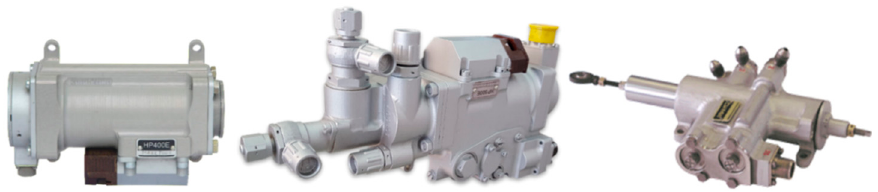
Figure 1. JSC ‘FED’ electrically driven fuel pumps without ( left ) and with ( middle ) integrated booster stage and fuel divider; Guide vanes actuator ( right ).